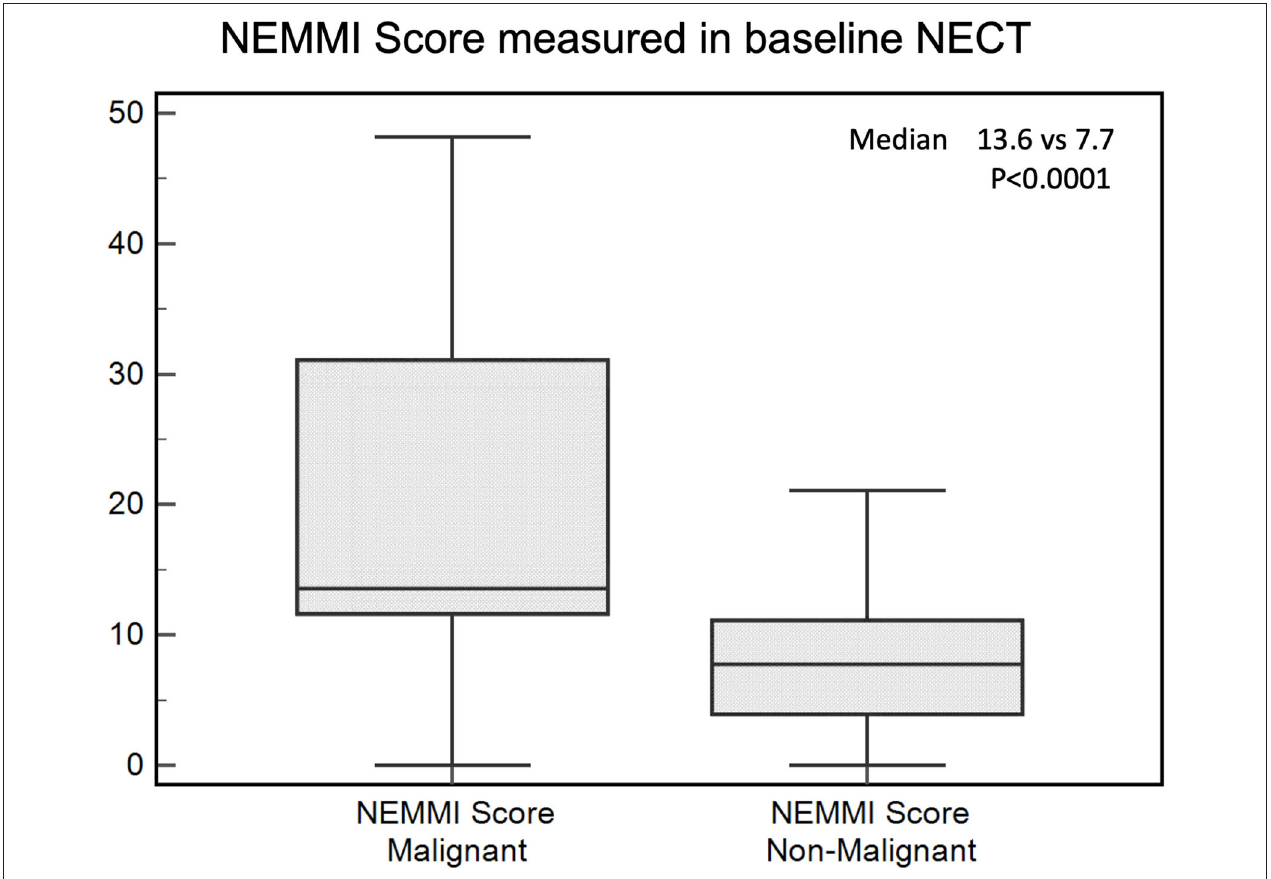
FIGURE 3 | NEMMI scores assessed for patients with subsequent malignant (MMI) and non-malignant course. Medians are illustrated as boxplots with the corresponding interquartile ranges. The NEMMI score was significantly elevated in patients with subsequent